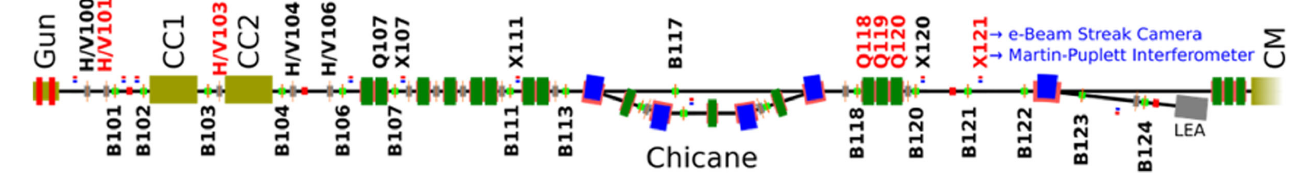
FIG. 1. Schematic of the FAST beam-line layout showing the capture cavities, correctors, rf BPMs, chicane, X121 OTR screen, spectrometer, and the beginning of the cryomodule (CM).